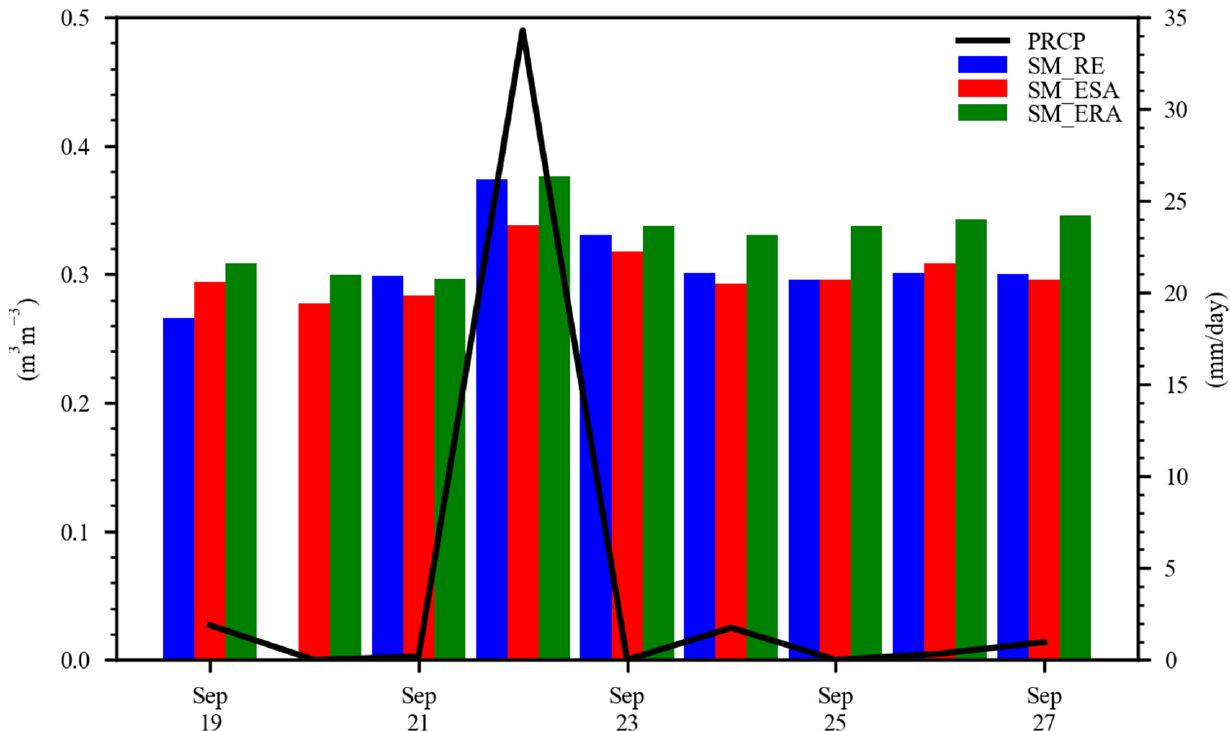
Figure 9. Soil moisture variation over time in the course of a rainy event. The blue bars indicate the retrieved soil moisture, the red bars indicate the ESA-CCI-based soil moisture, and the green bars indicate the ERA-based soil moisture. The solid curve indicates the daily precipitation amount.